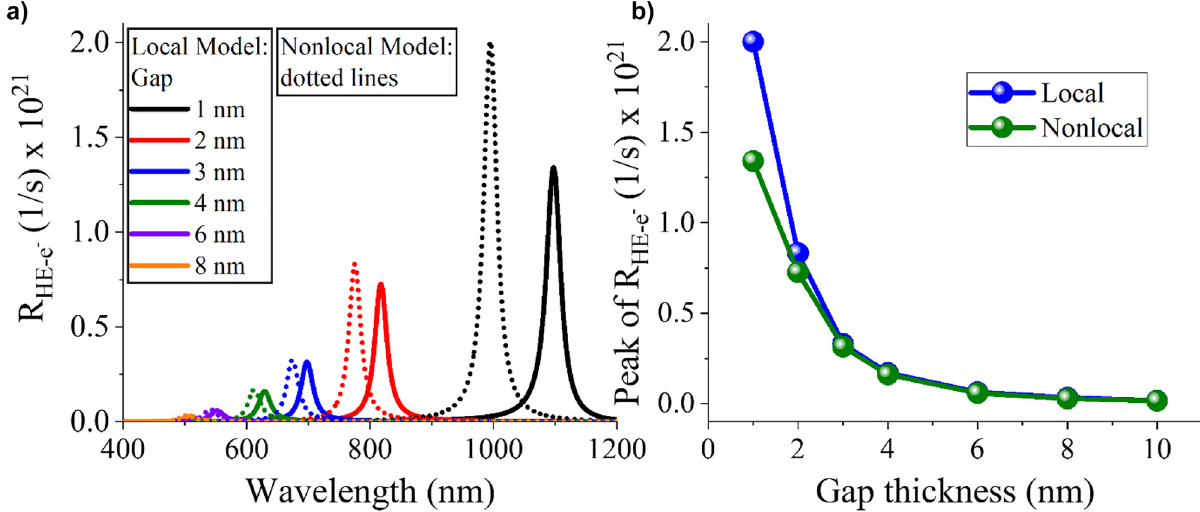
Figure 4: Comparison of hot electron generation between the local and nonlocal models. (a) Generation rate of hot electrons as a function of the wavelength excitation for various nanogap thicknesses computed by the local and nonlocal model. (b) The maximum hot electron generation rate at the resonance peaks shown in (a) calculated by local and nonlocal